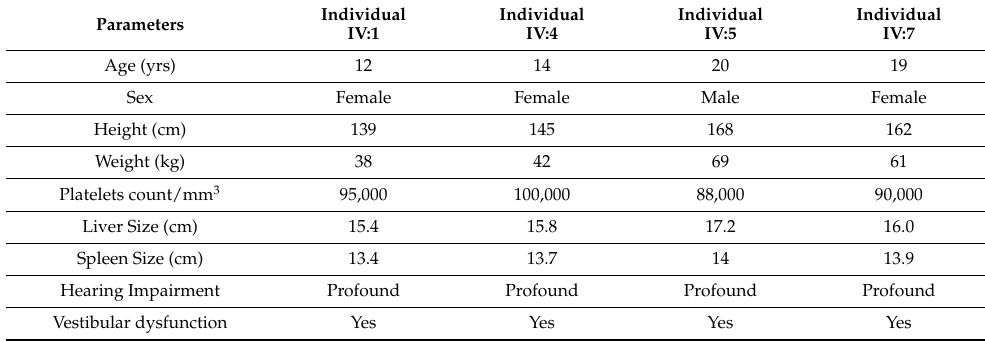
Table 2. Clinical parameters of affected individuals of family DEM4599.